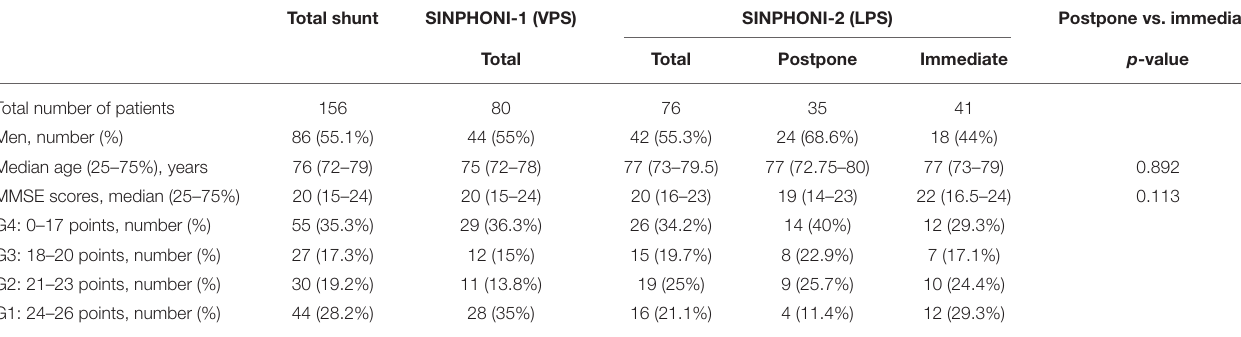
TABLE 1 | Baseline characteristics before the tap test.